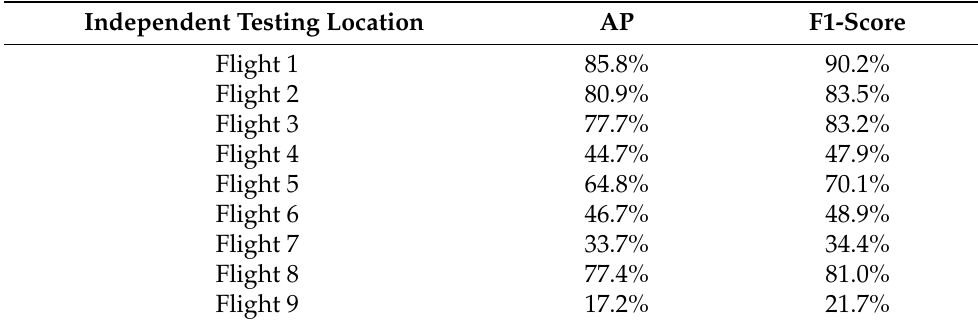
Table 8. Metrics on the Independent Testing